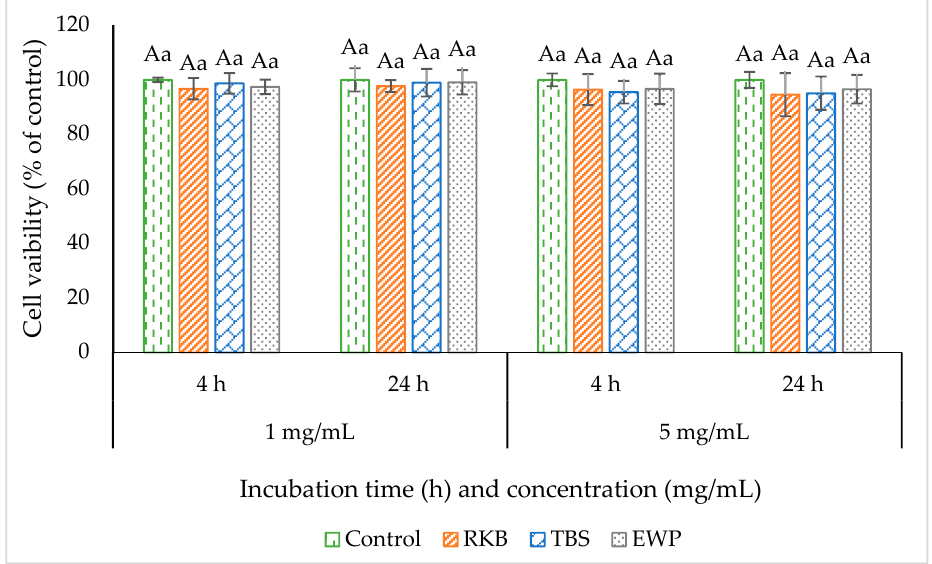
Figure 5. Effect of red kidney bean protein (RKB)-, threadfin bream surimi (TBS)- and egg white protein (EWP)-digested samples on the cell viability of Caco-2 cells (% of control). Different uppercase letters on the bars within the same incubation time denote significant differences ( p < 0.05). Different lowercase letters on the bars within the same concentration denote significant differences ( p < 0.05). Error bars represent standard deviation ( n = 3).